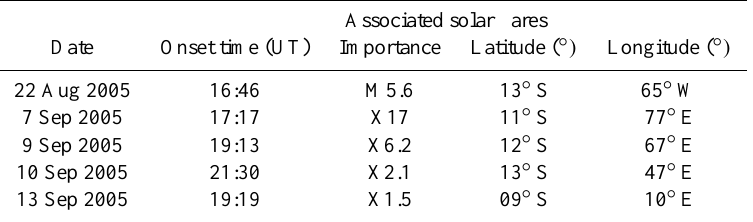
Table 1. The most significant solar flare events related to cosmic ray irregular behavior during August–September 2005. Solar flare date, onset time and class (importance), as well as heliographic location (latitude and longitude) on the face of the Sun are listed for each